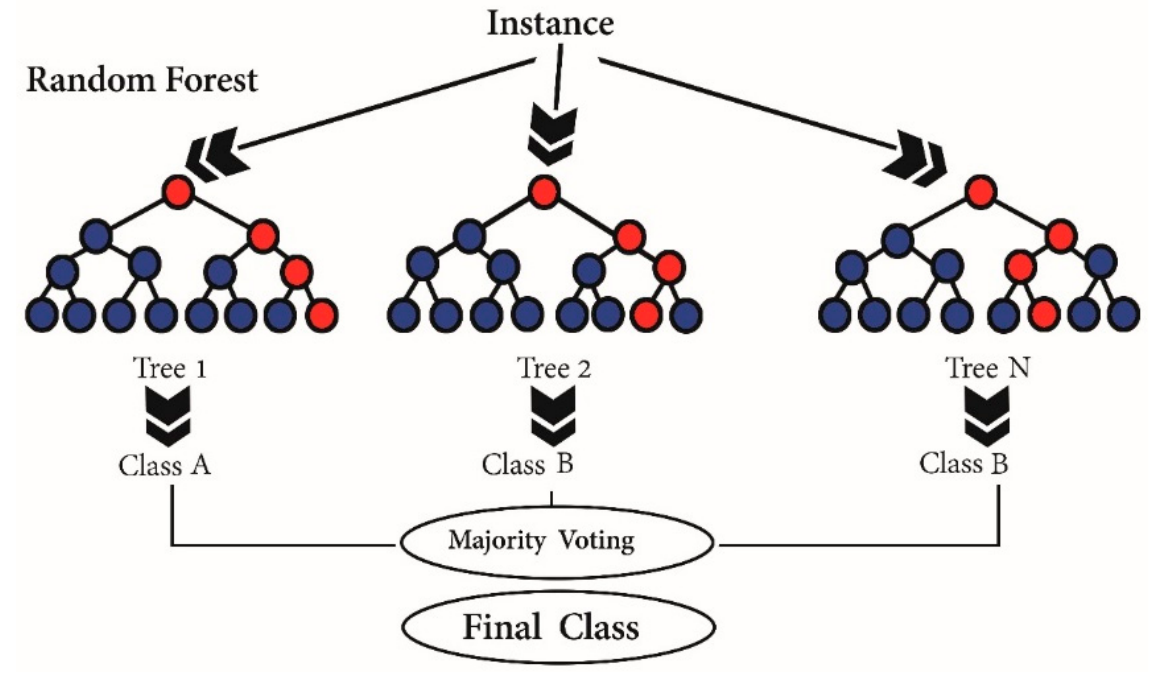
Figure 3. An example structure of the random forest algorithm.